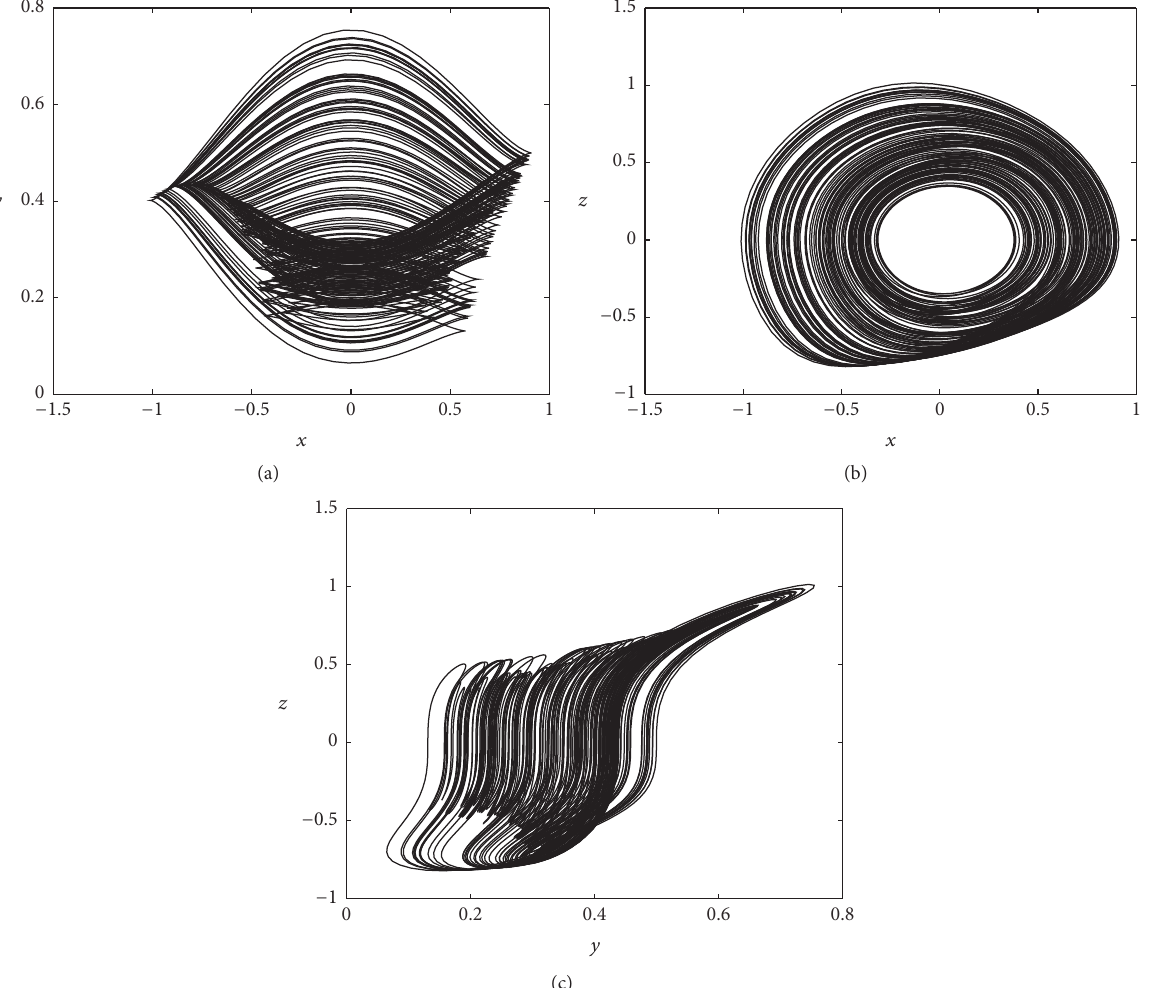
Figure 1: Chaotic attractor of the system with infinite equilibria (1) in (a) 𝑥 - 𝑦 plane, (b) 𝑥 - 𝑧 plane, and (c) 𝑦 - 𝑧 plane.